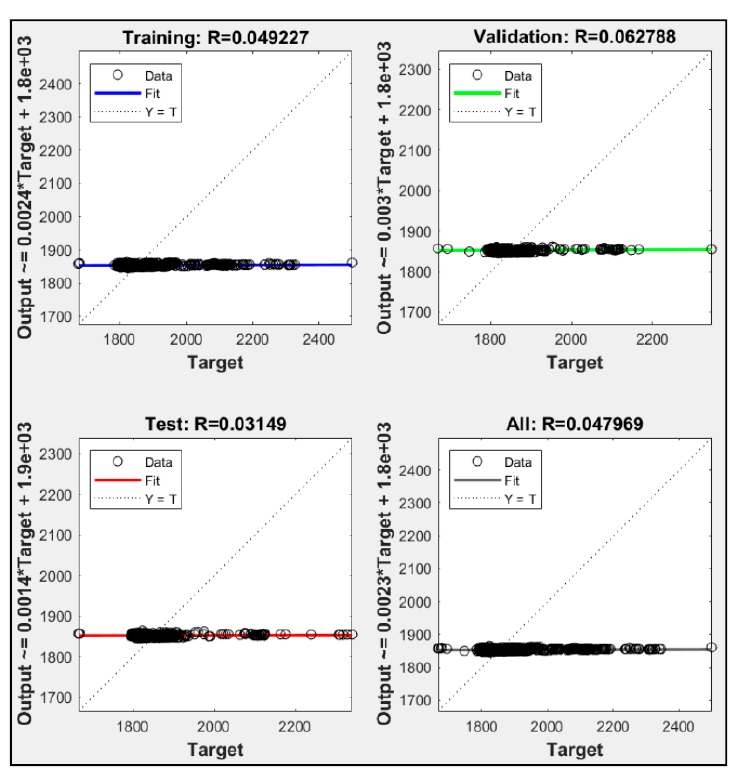
Figure 7. P2 regression result.